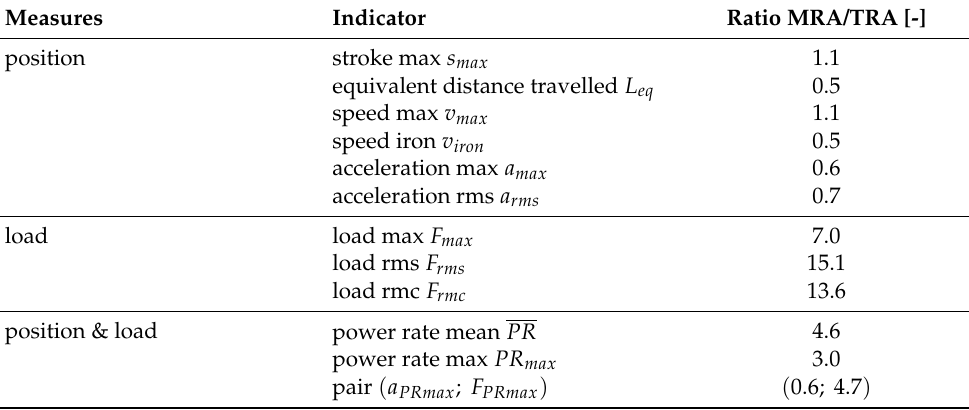
Table 1. VSR700 specification for MRA and TRA. a is the acceleration, F is the load; they come from measures on the VSR700 helicopter PFCS. PR = F ( t ) · a ( t ) is the power rate. The mean power rate PR = | < F ( t ) · a ( t ) > | takes an absolute value to be conservative. v iron is a mean value of speed representative of motor iron losses. F RMC is an equivalent rolling fatigue load based on 10 6 cycles.